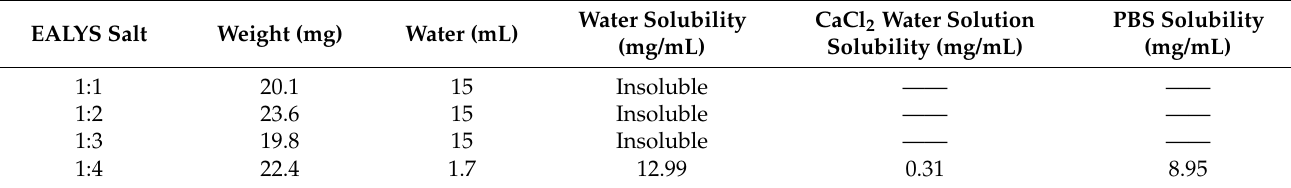
Table 2. Water solubility of EALYS